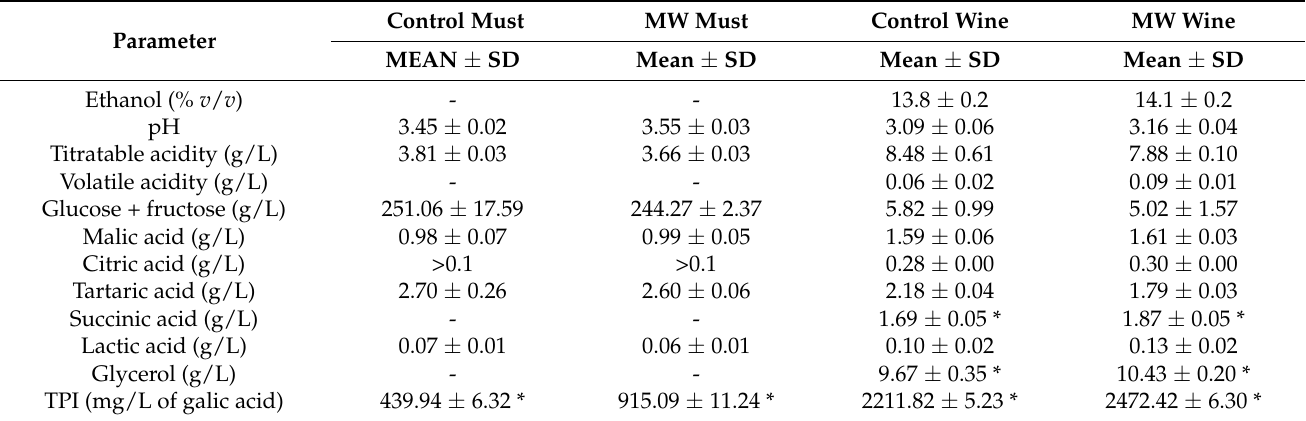
Table 2. Basic chemical composition parameters of musts and wines (control samples and samples from microwave treatment).